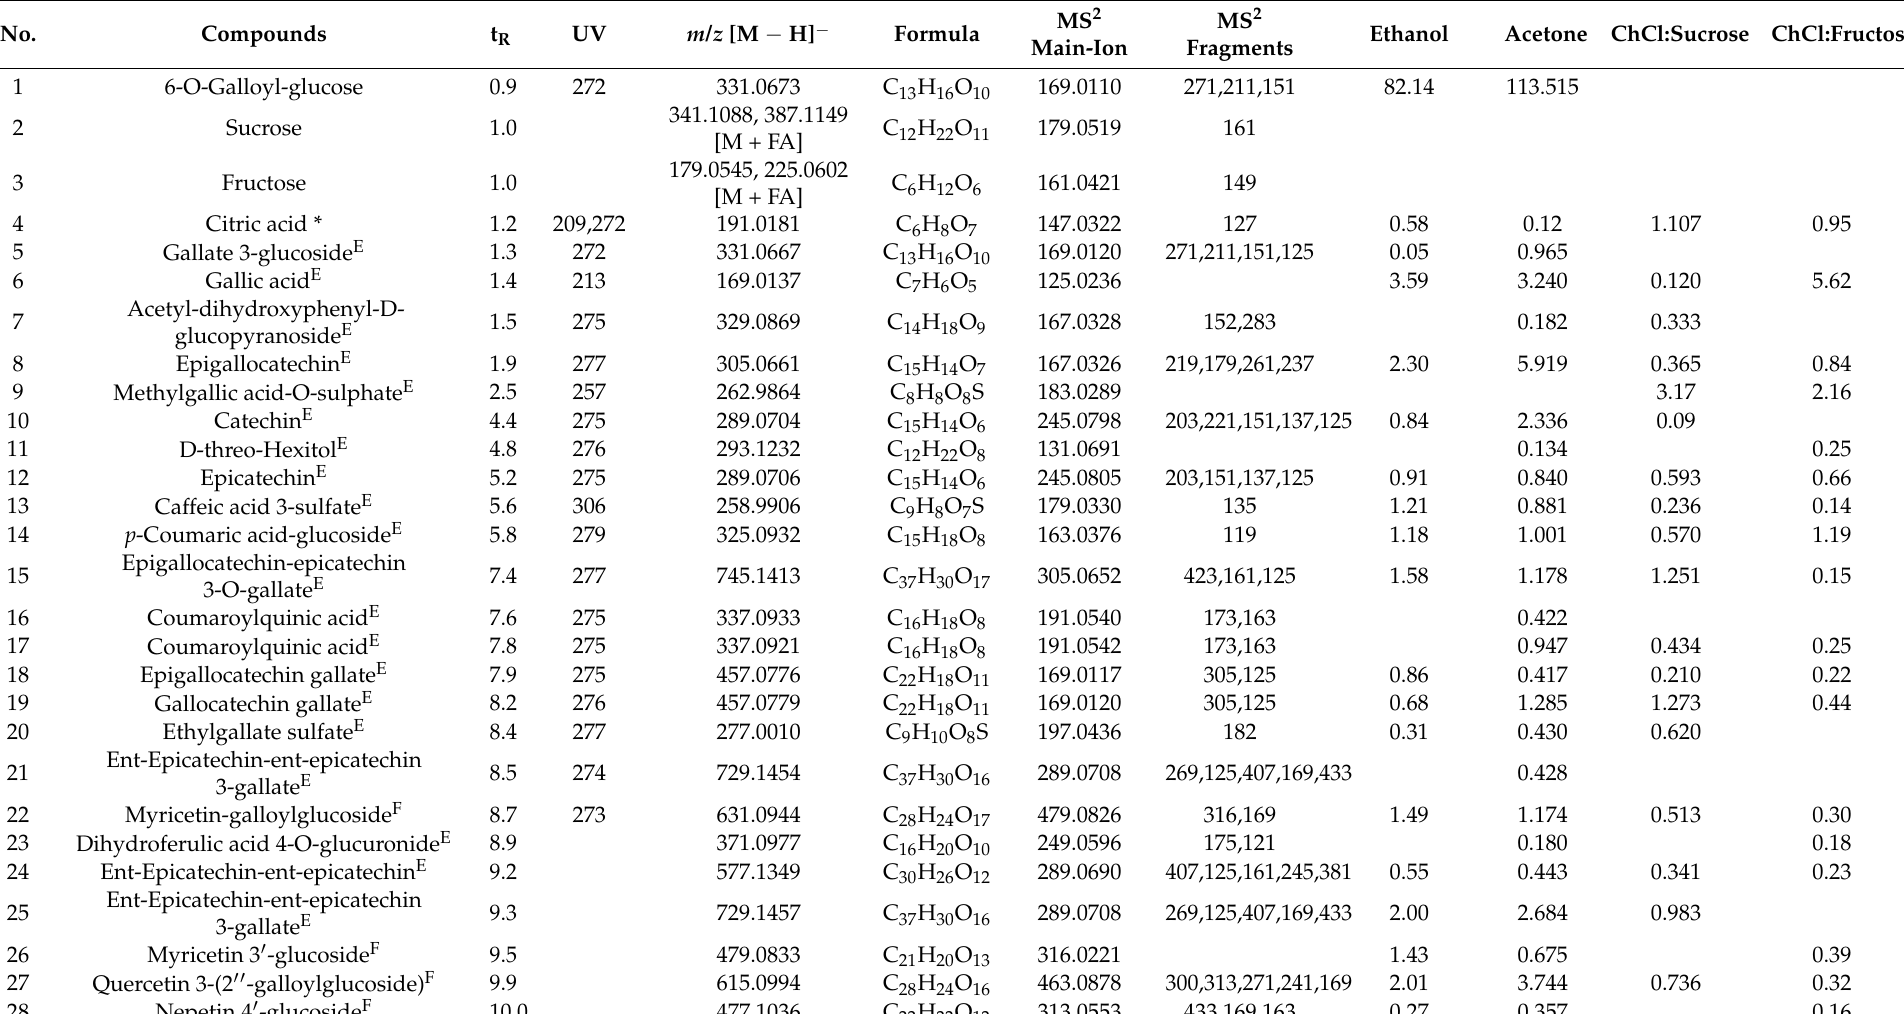
Table 2. LC-ESI-qTOF-MS analysis of the extracts from Polygonum maritimum L. (sea knotgrass) with annotated peaks and semi-quantitative determination * of selected phenolic compounds. Identification was based on our previous reports on sea knotgrass